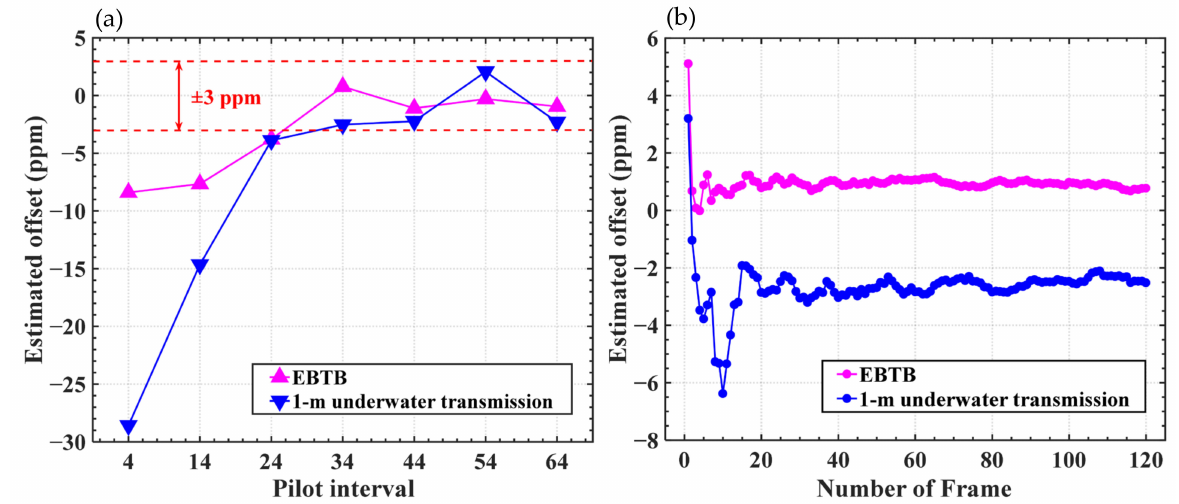
Figure 4. ( a ) The estimated offset at different pilot intervals; ( b ) The convergence performance versus frame number when the pilot interval is 34.